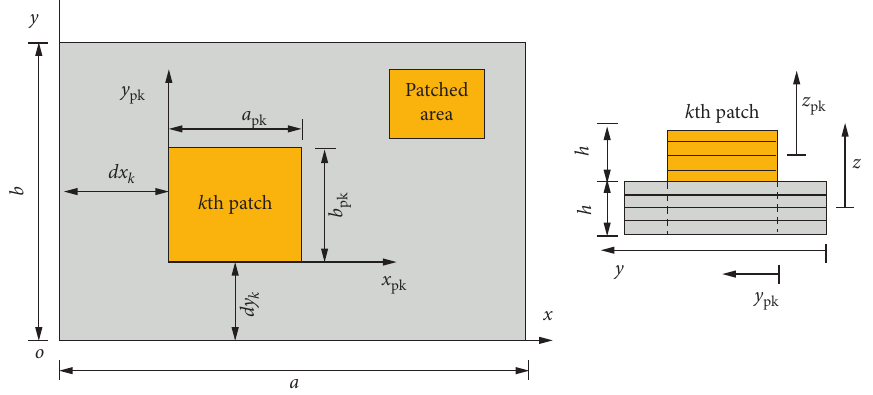
Figure 1: Geometry of a composite plate with surface-bonded composite patches and coordinate